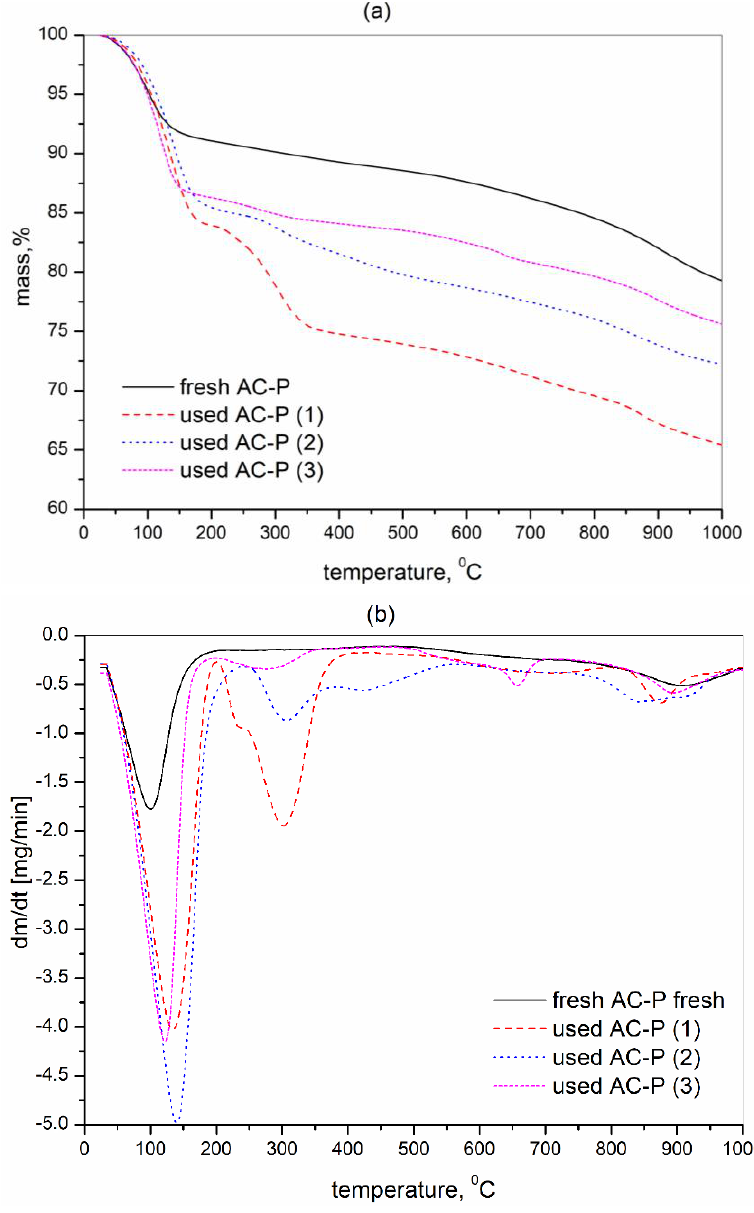
Figure 8. TG ( a ) and DTG ( b ) curves of activated carbon (fresh and after use in the deSO x and deNO x adsorber): fresh AC-P, used AC-P (1), used AC-P (2), and used AC-P (3). Different situations were observed for all spent AC-P-activated carbon. As indicated by the TG/DTG curves (Figure 8a,b), four types of mass loss were observed in the spent AC-P samples. The first type of mass loss (30–200 °C) was due to the desorption of surface water. The second type of mass loss (200–400 °C) resulted from the removal of water from the pores of the adsorbent. The third type of mass loss (440–650 °C) was due to the de- sorption of sulfur. The fourth type of mass loss (>650 °C) resulted from the decomposition of potassium sulfate. All completed analyses demonstrated that the mechanism of deep flue gas purification on the activated carbon using AC-P involved the reaction of SO 2 to K 2 SO 3 and, through oxidation of SO 2 to SO 3 and adsorption, a reaction to K 2 SO 4 . The pres- ence of these compounds was confirmed by XRD, SEM-EDX, and TG analyses. However, the presence of nitrogen oxide removal products was not observed, indicating that nitro- gen oxides, especially NO, were not oxidized in the desulfurization unit to N 2 O 5 and N 2 O 4 and thus did not react with KOH to produce potassium nitrites and nitrates (KNO 2, KNO 3 ). The FTIR, XRD, SEM-EDX, and TG analyses also did not confirm the existence of these compounds. A previous study carried out by the present authors also confirmed that NO x was not removed from flue gas before CO 2 adsorption in a special section [9]. According to these studies, a large part of the NO x was adsorbed—not in the desulfuriza- tion and NO x removal section, but in the CO 2 separation section, thus contaminating the activated carbon. The used activated carbon materials (in the four adsorption columns— CO 2 separation section) featured increased nitrogen content, which suggested the slight adsorption of NO x captured from the flue gas. Details of this analysis can be found in [9]. Many of the same results were obtained by Lee et al. [29] during a study on the surface of impregnated activated carbon after NO x and SO 2 adsorption. The authors observed that in most cases, adsorption proceeded during chemical reactions. Due to the presence of OH groups on the surface, the KOH-impregnated activated carbon oxidized due to NO x and SO 2 adsorption. In particular, SO 2 presented strong interactions with KOH-impreg- nated activated carbon, forming K 2 SO 4 on the external surface of activated carbon. Lee et al. [29] also observed that more SO 2 adsorbed on the surface of KOH-impregnated acti- vated carbon corresponded to less NO x being adsorbed. The authors in [29] showed that the individual adsorption of NO x and SO 2 proceeded differently than the simultaneous